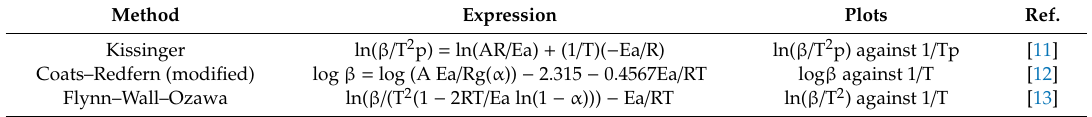
Table 1. Methods for determining Ea of CNF / NC composites